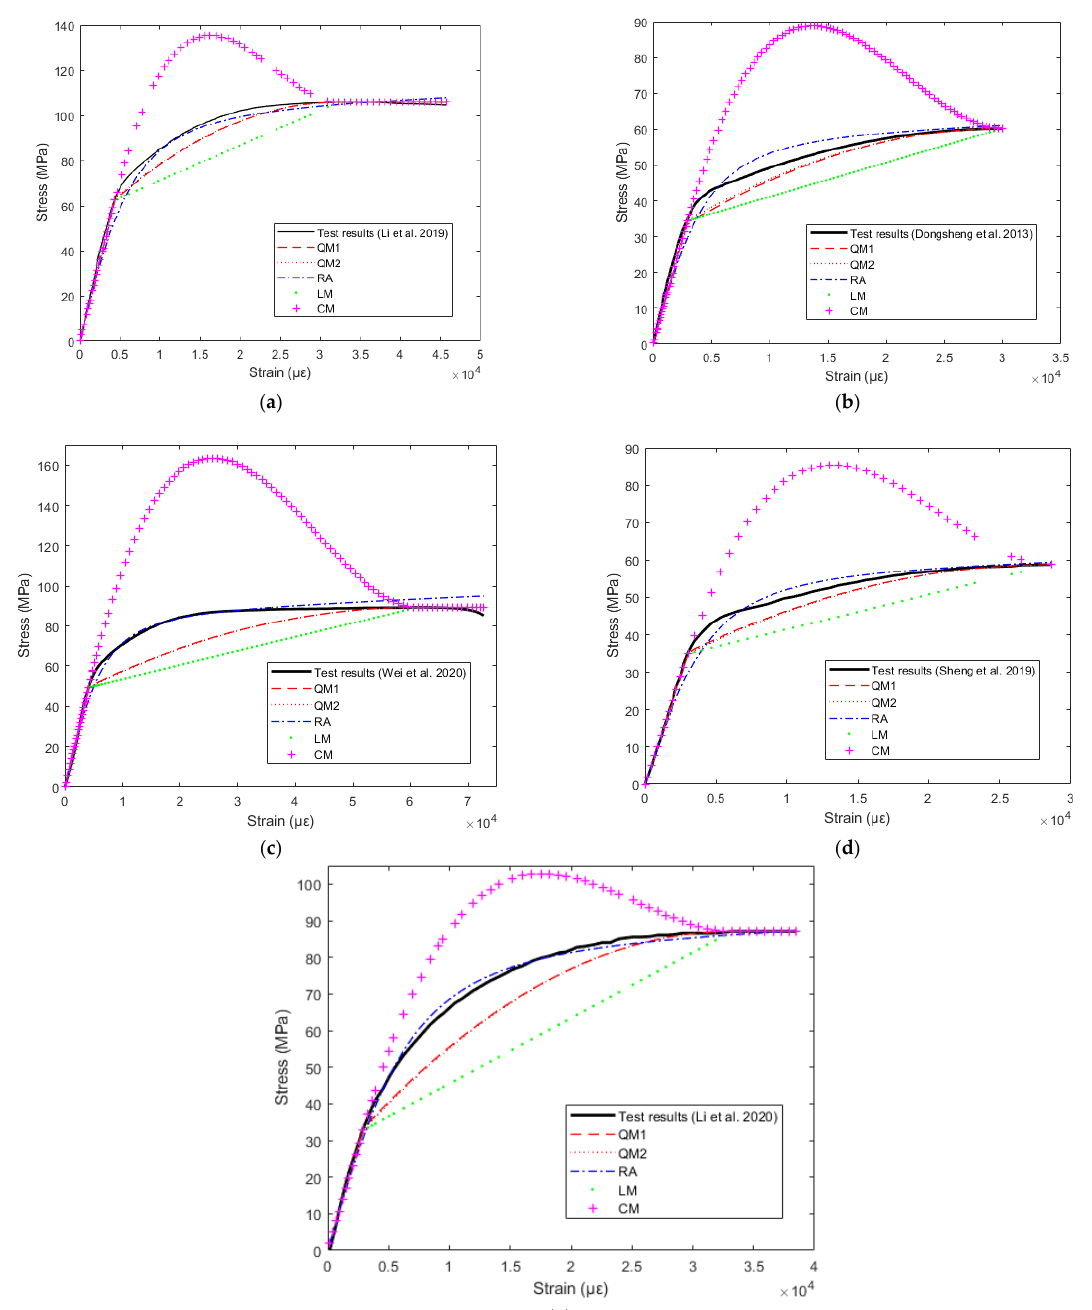
Figure 5. Comparison of the existing models with experimental curves: ( a ) Li et al., 2019 [19], ( b ) Dongsheng et al., 2013 [45], ( c ) Wei et al., 2020 [46], ( d ) Sheng et al., 2019 [47] and ( e ) Li et al., 2020 [48].